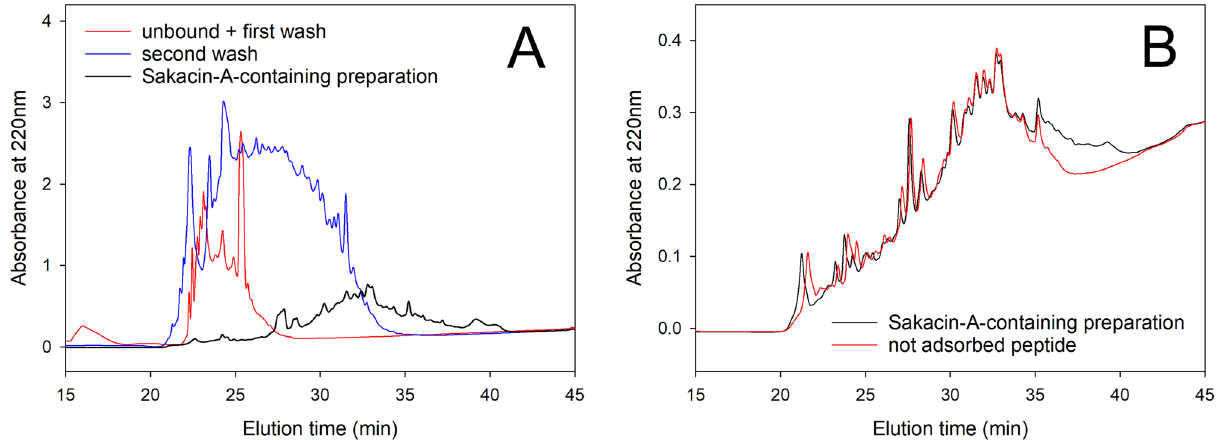
Figure 2. Sakacin-A purification and conjugation with BCNCs. ( A ) enrichment procedure of Sakacin-A. RP-HPLC chromatograms of unbound fraction plus the first wash (red), second wash (blue) and Sakacin- A-containing preparation (black); ( B ) conjugation of Sakacin-A to BCNCs. RP-HPLC chromatograms of Sakacin-A-containing preparation (black), and supernatant fraction residual after conjugation (i.e. not adsorbed peptides) (red). The linear increase of the baseline over time was due to the spectroscopic properties of ACN.